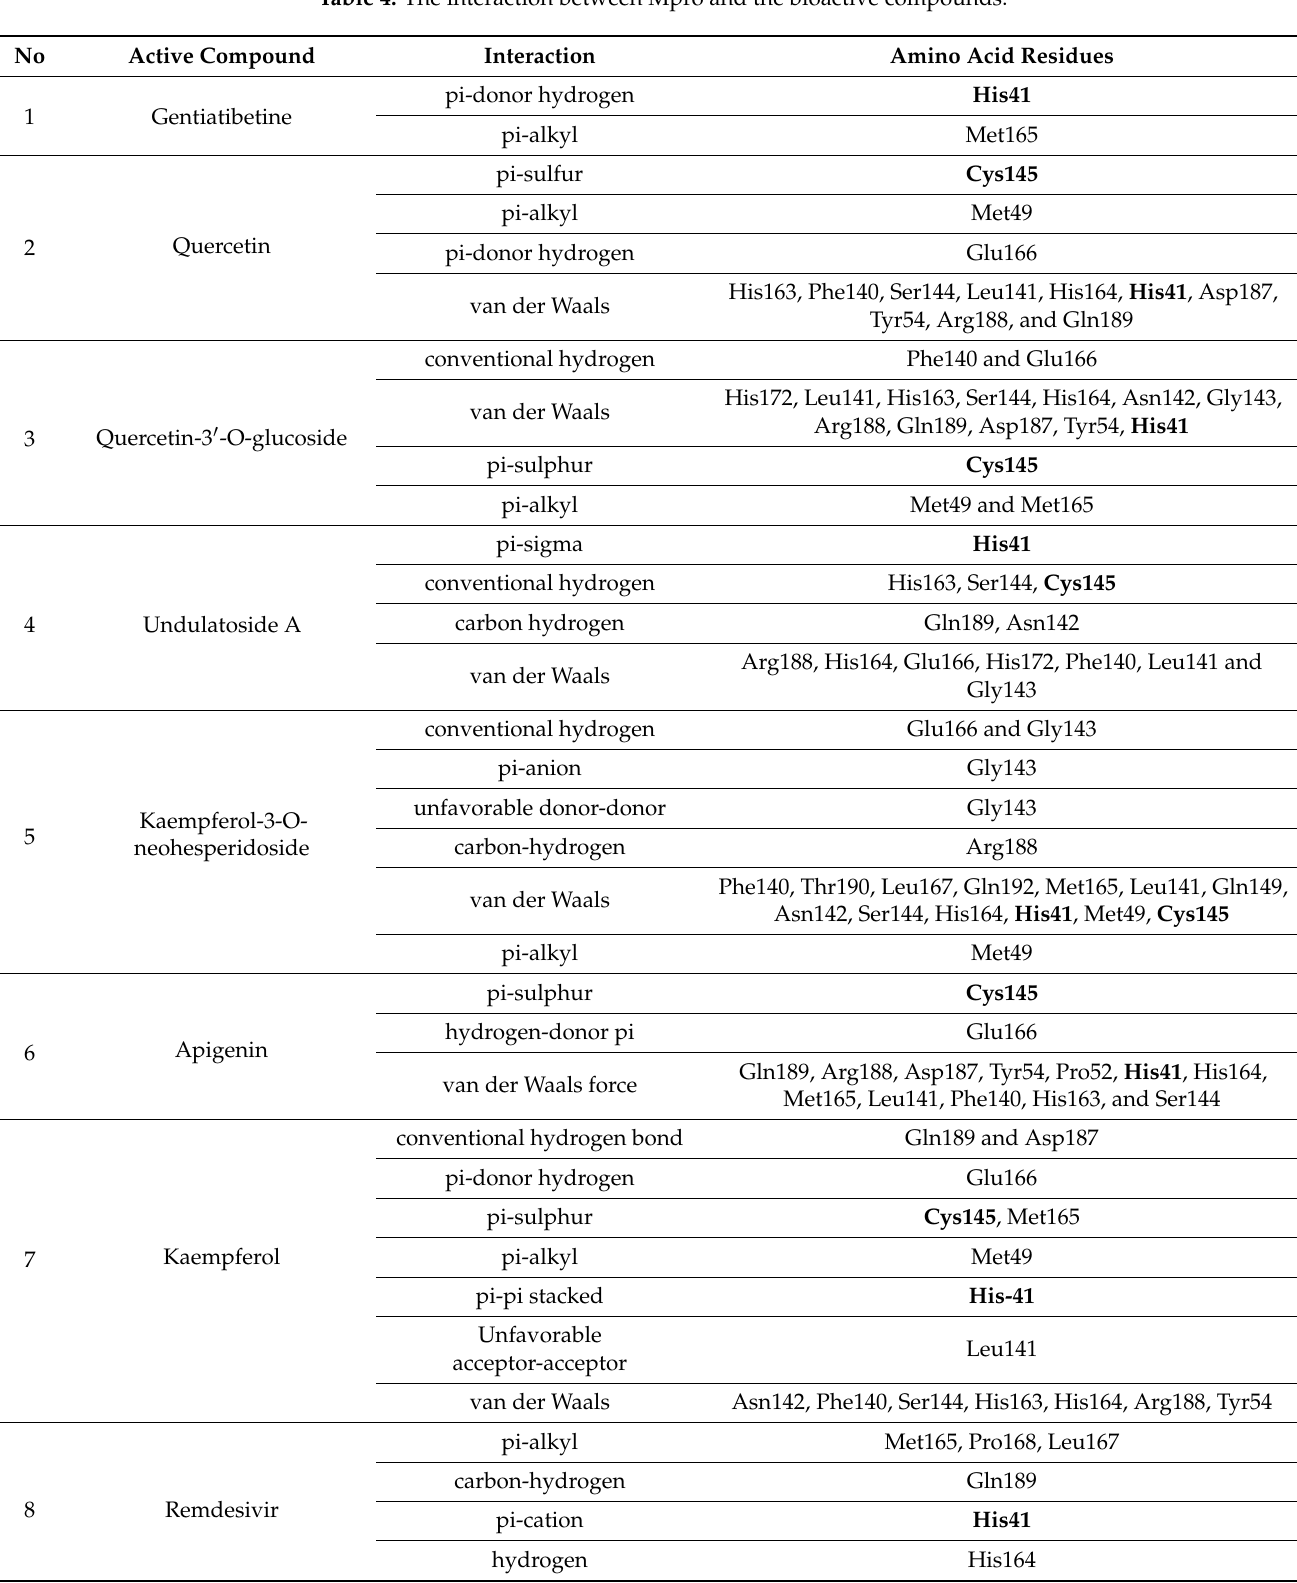
Table 4. The interaction between Mpro and the bioactive